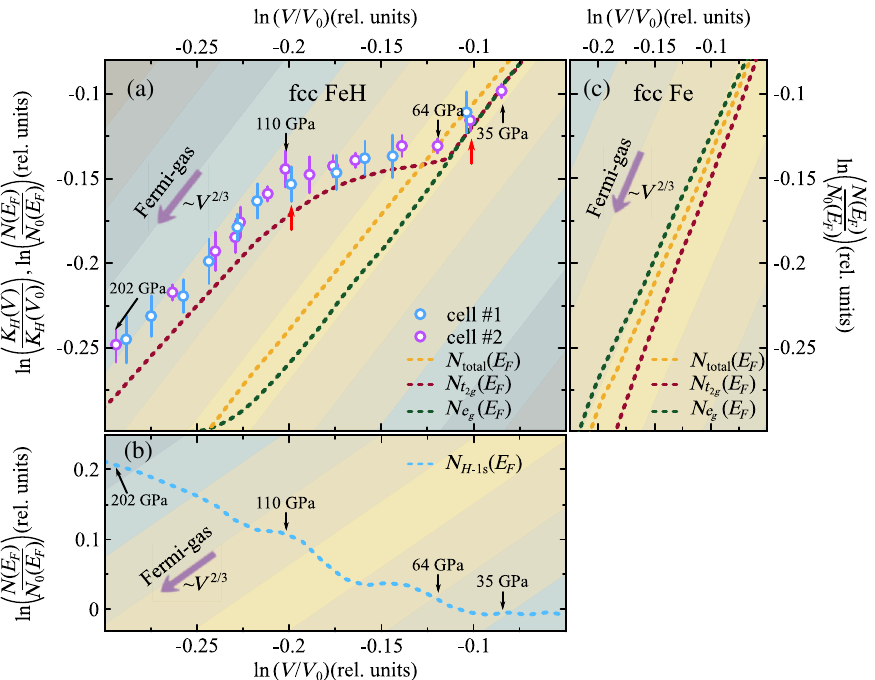
FIG. 3. Comparison of experimental data and ab initio electronic density of states calculations. (a) Double logarithmic power plot of relative changes in K to V 0 using the equation of state from Narygina et al. [21] and extrapolated values of K of state data from Thompson et al. [28] or P´epin et al. [22] does not affect our conclusions. The dashed lines (splines through computed values) show the dependence of N scaling for free-electron Fermi-gas-like behavior [as N ð E Þ ∝ V denote respective pressures points; red arrows show data recorded under decompression. (b) Evolution of N markers are related to the experimental data points from (a). (c) Volume dependence of N a similar compression